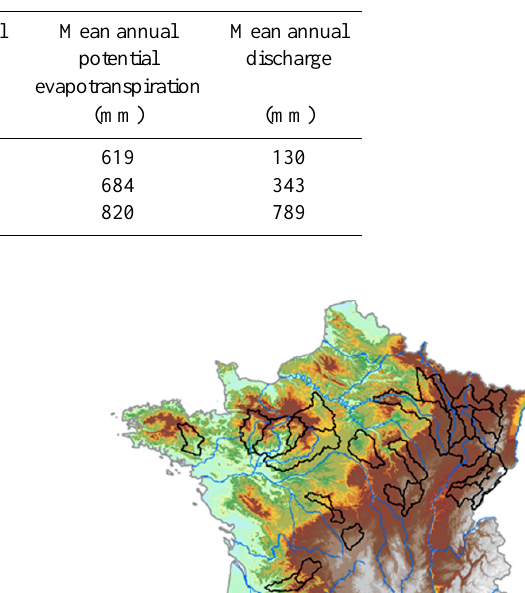
Table 1. Main characteristics of the studied catchments.